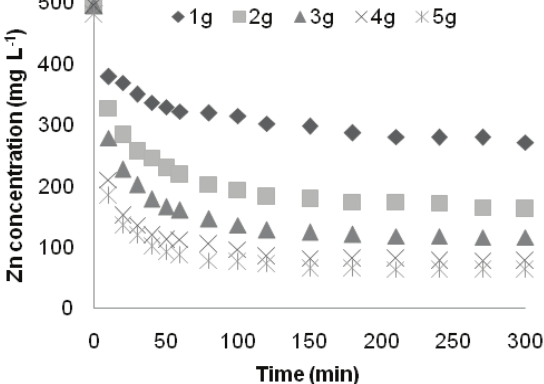
Figure 3. Effect of resin quantity on zinc sorption by Amberlite IRA410;